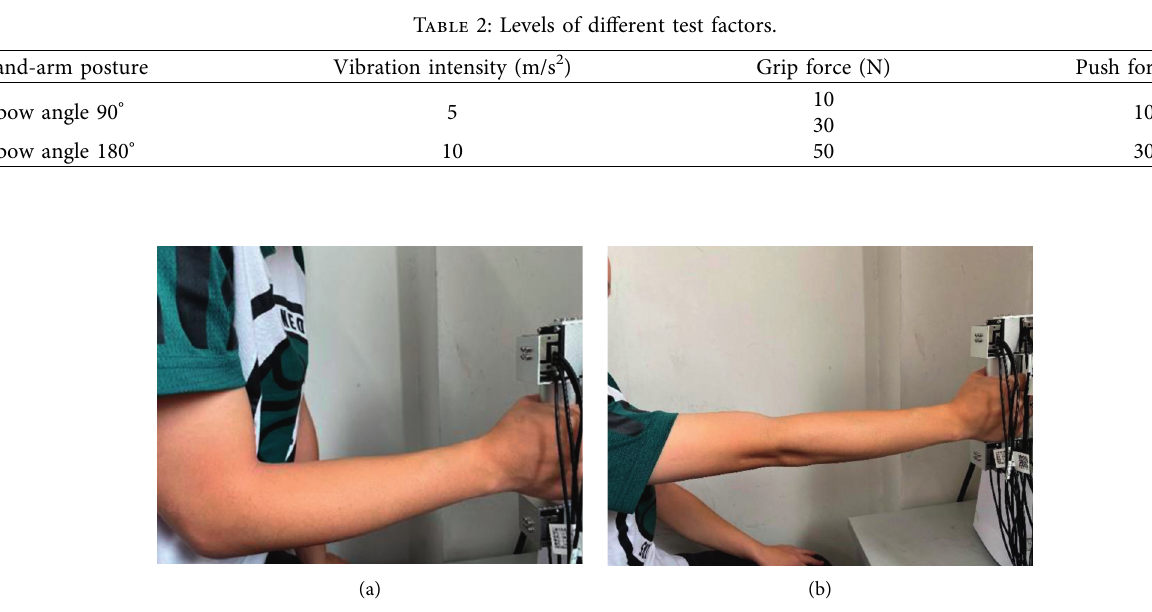
Figure 6: Hand-arm posture in the mechanical impedance test. (a) 90 ° elbow angle. (b) 180 ° elbow angle.